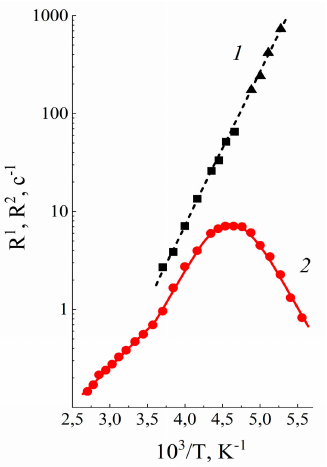
Figure 24. Temperature dependences of spin–lattice (R 1 —curve 2) and spin–spin (R 2 —curve 1) relaxation rates of 7 Li lithium cation nuclei in Li + ionic form of MF-4SC membrane at water content λ = 20.5 water molecules per sulfonate group (adapted from